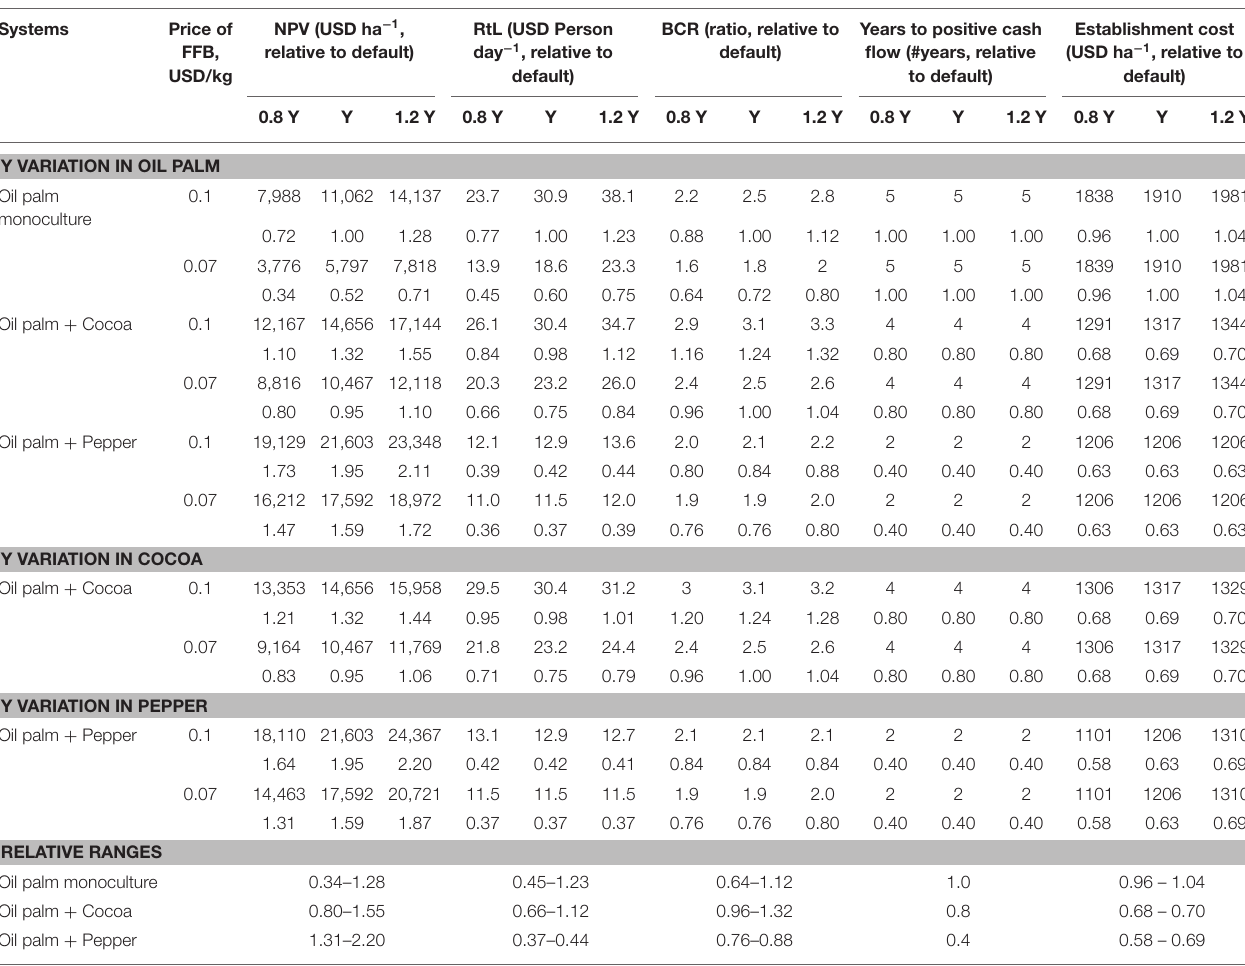
TABLE 7 | Economic performance indicators Net Present Value (NPV), return to labour (RtL), Benefit Cost Ratio (BCR), years to positive cash flow and cost of establishment, for each simulated scenario with added uncertainty in physical yield (from 0.8 to 1.2 times the default value for oil palm, cocoa or pepper) and Fresh Fruit Bunch (FFB) prices (from 0.1 to 0.07 USD kg − 1